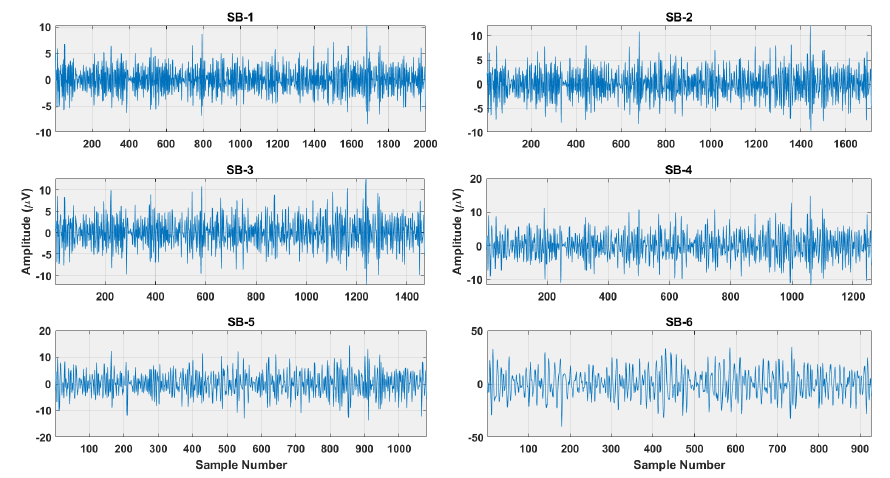
Figure 3. The subbands of RF brain activity obtained after r-TQWT decomposition.